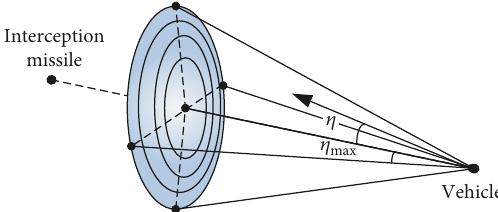
Figure 2: The three-dimensional interception attack